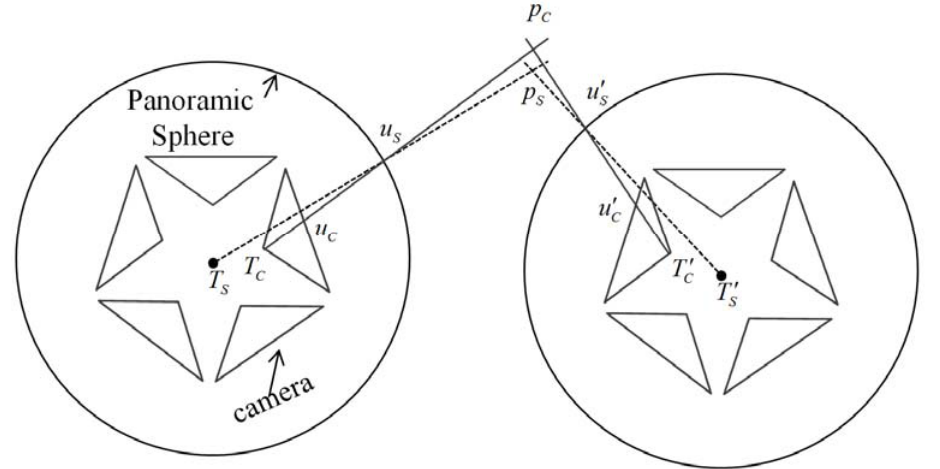
Figure 2. Representation of a panoramic camera consisting of five mono cameras. The dashed line on the left indicates an ideal ray corresponding to ideal sensor model that passes through the panoramic centre T , a point on the panoramic sphere u S . In reality, u is imaged from the mono camera, and the projection centre is T p s s ray is represented by the solid line corresponding to our rigorous sensor model and passes through T , u and p . Two errors are introduced by the ideal model: one is the ray direction c s c bias, and the other is the position offset of the